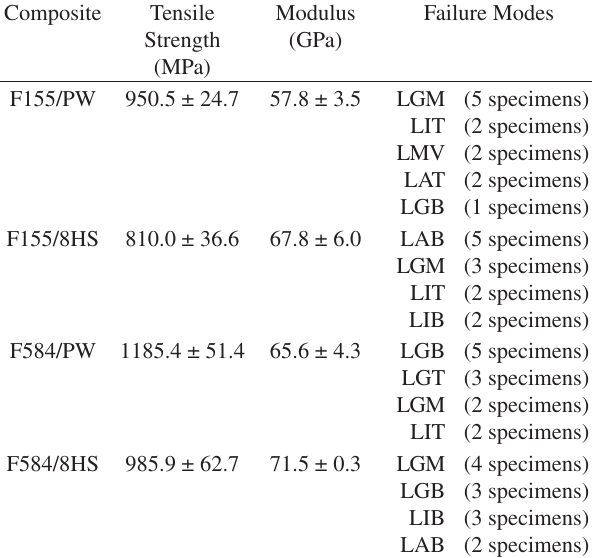
Table 5. Results of tensile tests of the composites.